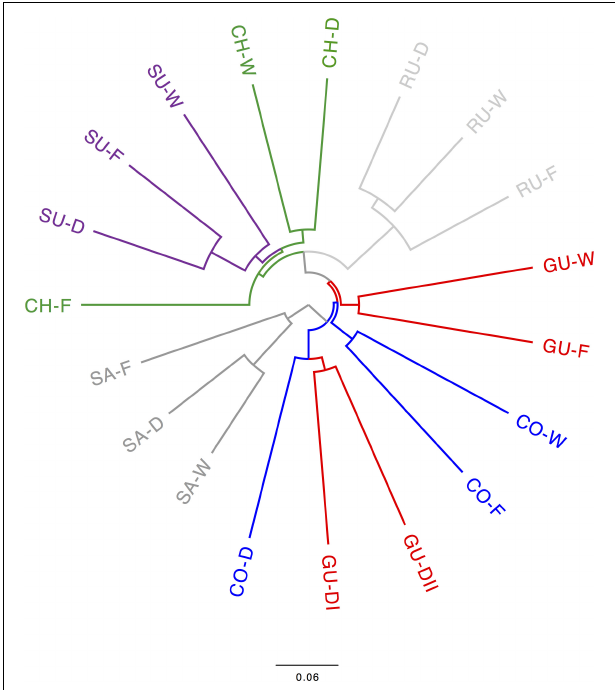
FIGURE 4 | Consensus SNAPP-based phylogenetic tree of the Espeletia populations analyzed in the current study. Populations from Santurbán (SA) were used as outgroups for rooting the phylogenetic tree following Diazgranados and Barber (2017). Localities and ecotypes are colored and coded as in Figure 1